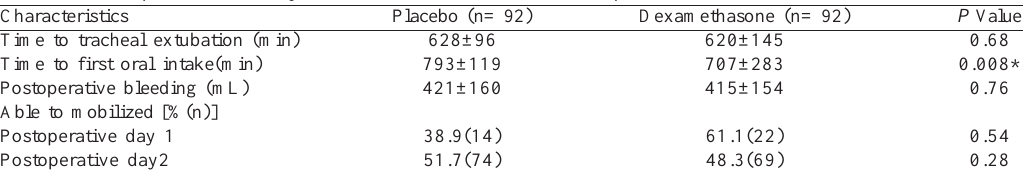
Table 2. Postoperative recovery Characteristic of the Patient Groups Characteristics Time to tracheal extubation (min) Time to first oral intake(min) Postoperative bleeding (mL) Able to mobilized [%(n)] Postoperative day